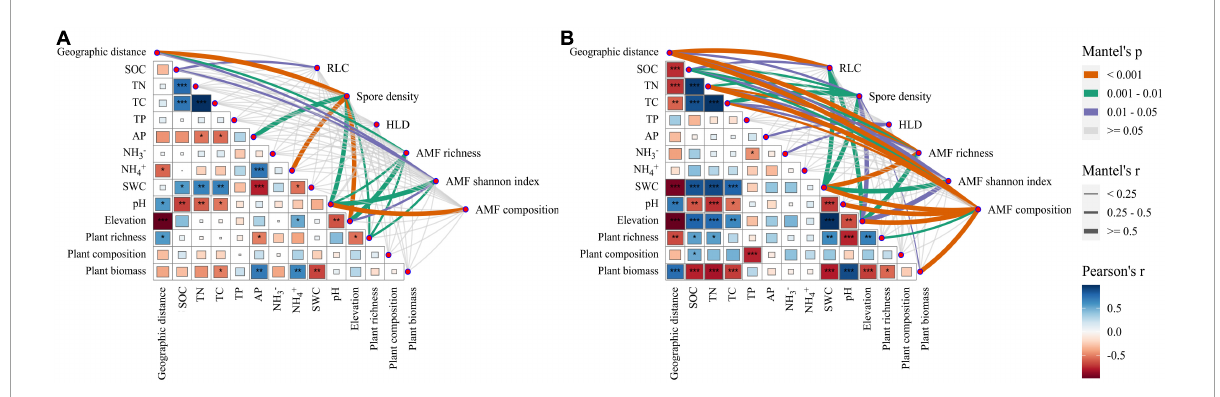
FIGURE7 Relationships between AM fungal abundance, α diversity, and community composition with environmental factors in the near (A) and far (B) bank soils. The relationships among environmental variables were illustrated by Pearson correlation (* P < 0. 05; ** P < 0.01; *** P < 0.001).